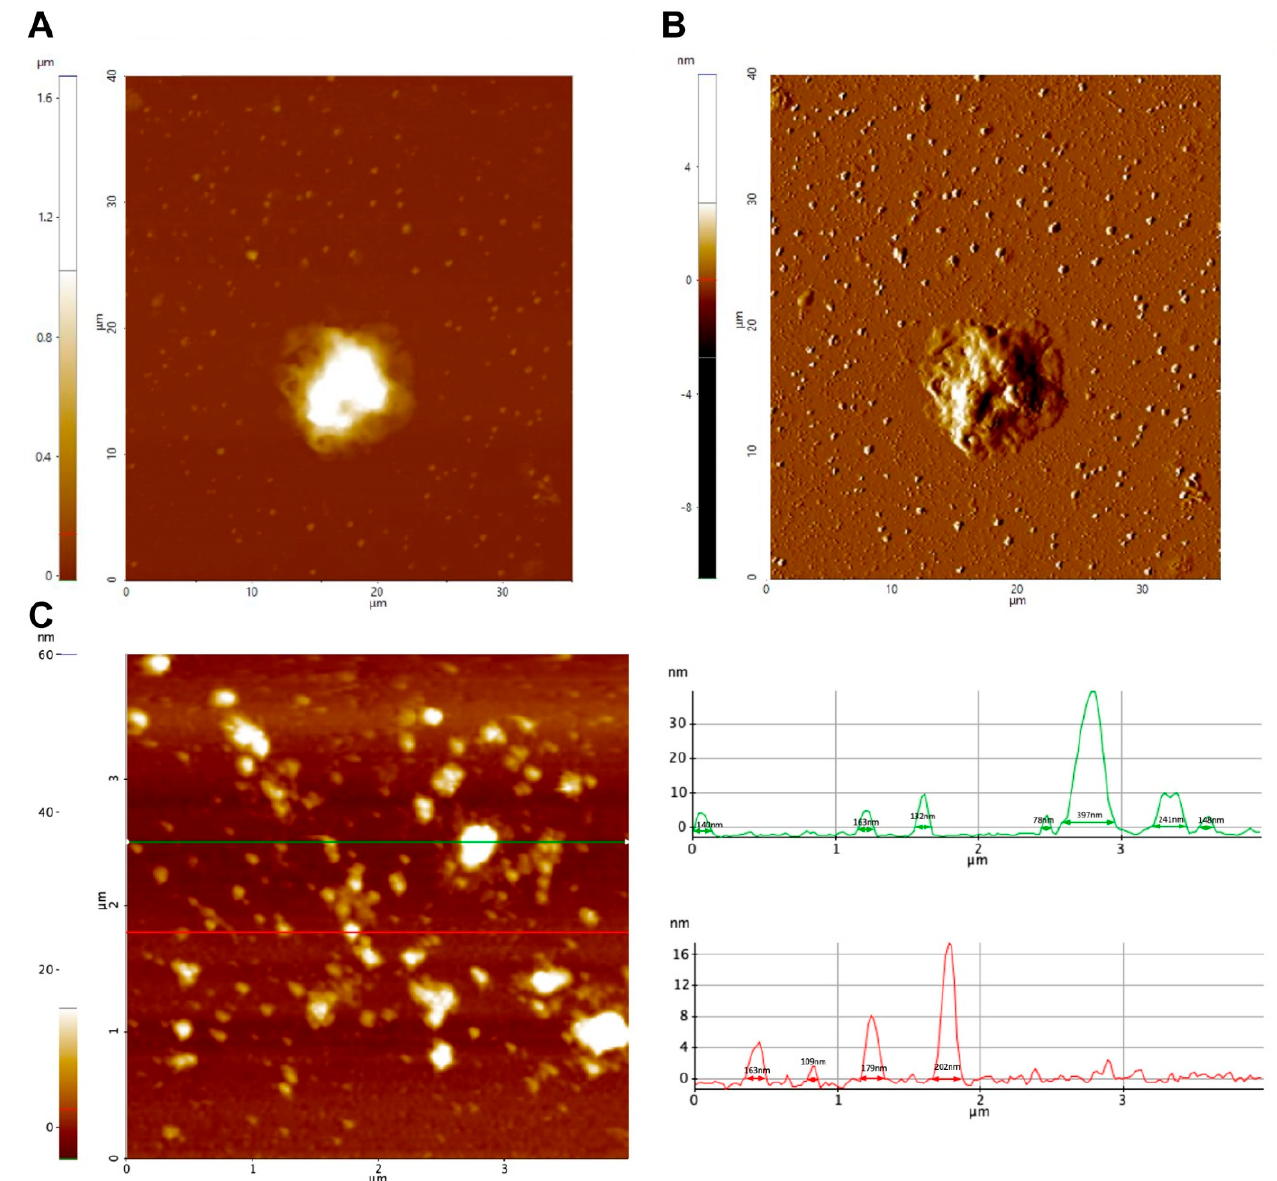
Figure 2. Atomic force microscopy analysis of extracellular vesicles of Naegleria fowleri . ( A ) Tropho- zoite surrounded by secreted extracellular vesicles (1 h incubation): ( A ) Z-height image and ( B ) am- plitude image. ( C ) Analysis of isolated pellets of EVs revealed the production of vesicles ranging from 30 nm to 400 nm in length and 4.5 nm to 40 nm in height. Representative images are shown.